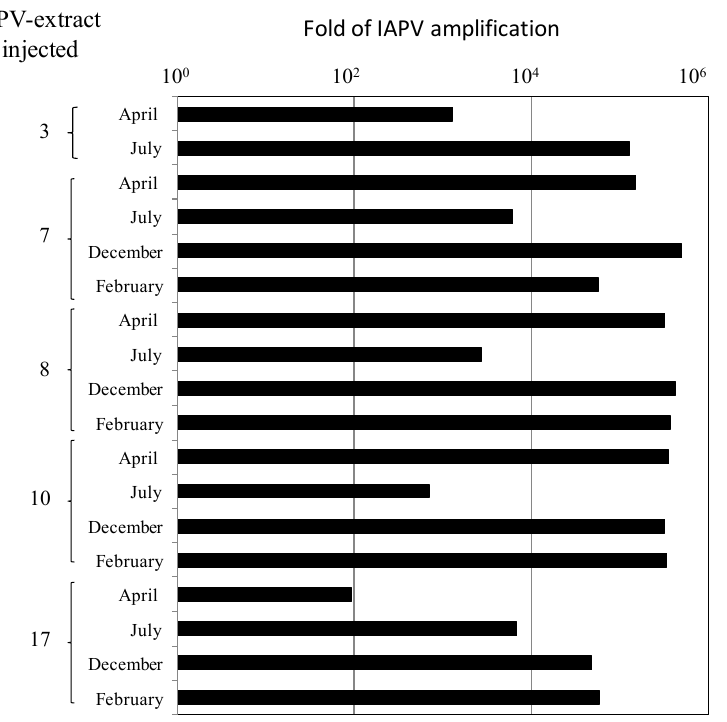
Figure 3. Infectivity of IAPV extracted from CCD-colonies. Virus-free pupae (white-eye) from a healthy colony were inoculated with IAPV-extracted from naturally infected bees from CCD- and 17-colonies. X-axis, amplification-fold of IAPV genomic copies at 72 h after injection of IAPV-extracted at various time points in the year, y-axis. (Dependent t-test, t = 3.27215, p < 0.01).